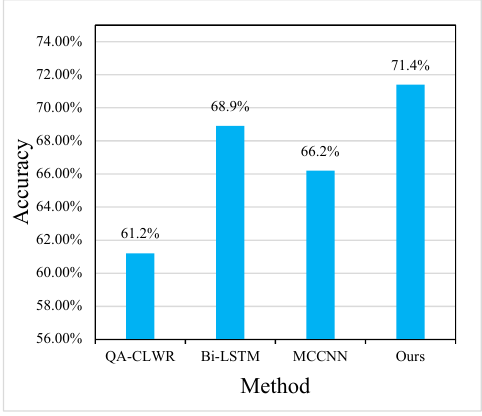
Figure 8. Accuracy performance of datasets.